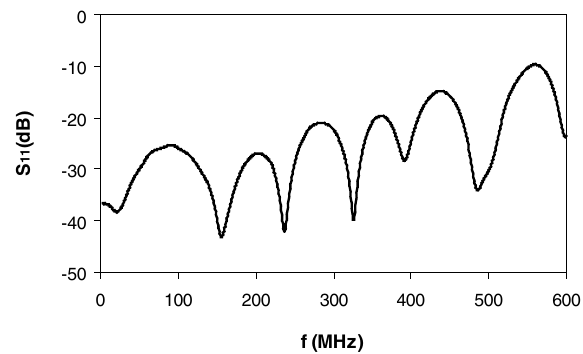
FIG. 18. S measurement for the manufactured coupler in 11 the relevant frequency